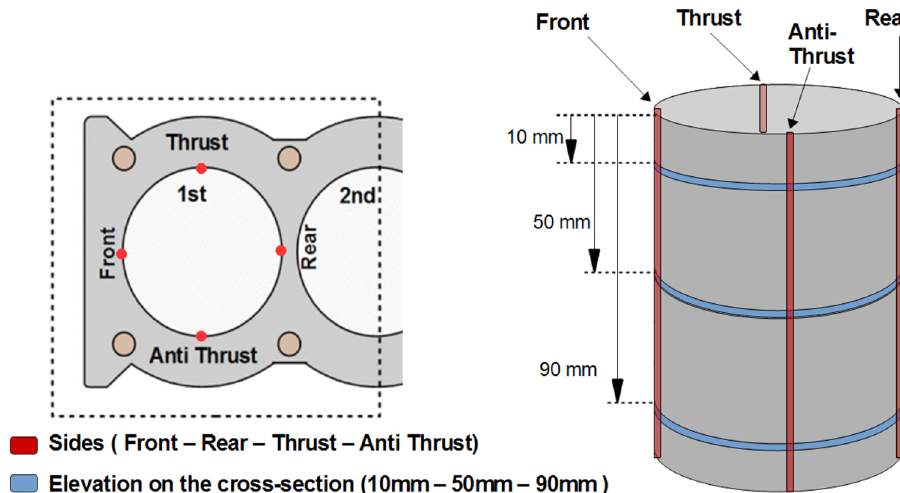
Figure 2. Locations and orientations of the deformation paths for the cylinder liner.